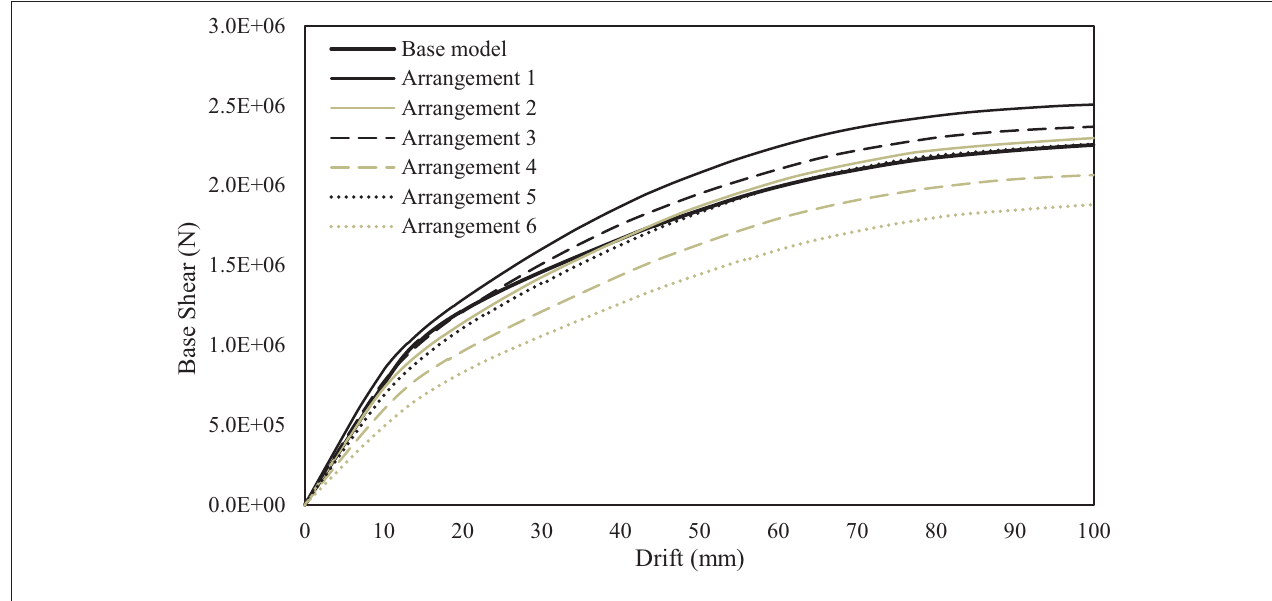
FIGURE 8 | One set of capacity response curves for SPSW models.